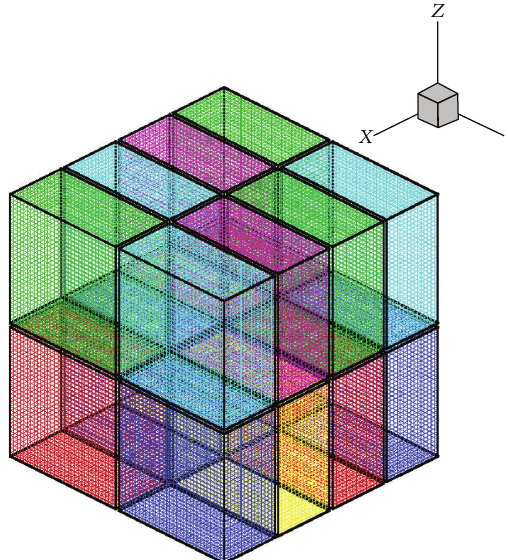
Figure 6: Mesh and domain decomposition for 64 × 64 × 64 grid with a 4 × 2 × 2 processor